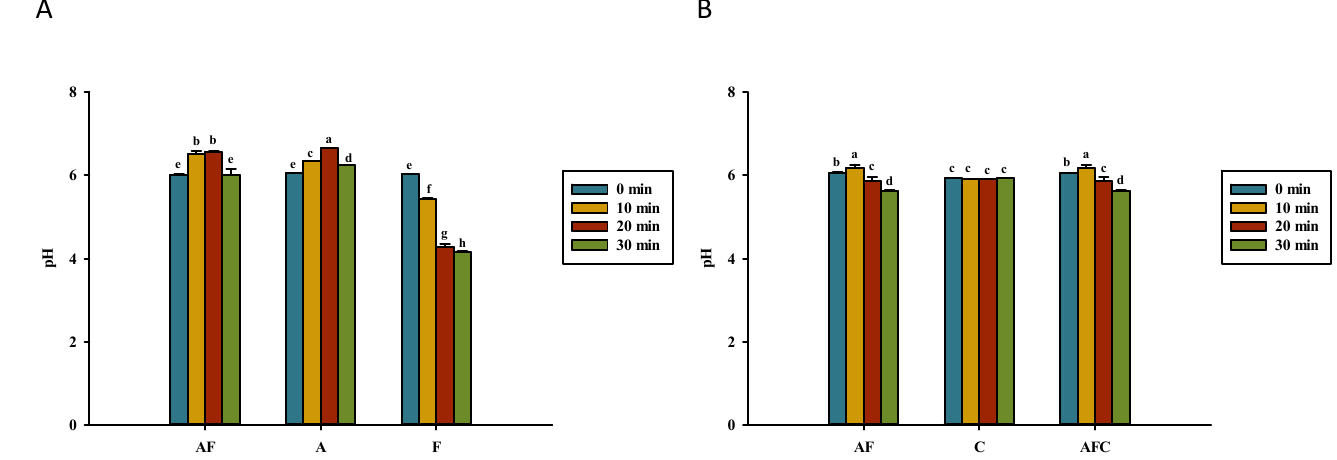
Figure 8. Comparison of pH values for various groups upon heating in ( A ) water and ( B ) acetic acid. AF, asparagine and fructose; A, asparagine; F, fructose; C, chitosan; AFC, asparagine, fructose, and chitosan. Data represent the means of three replicates, and error bars indicate standard deviation. Bars followed by a common letter are not significantly different according to the Dunn’s test at the 5% level of significance.